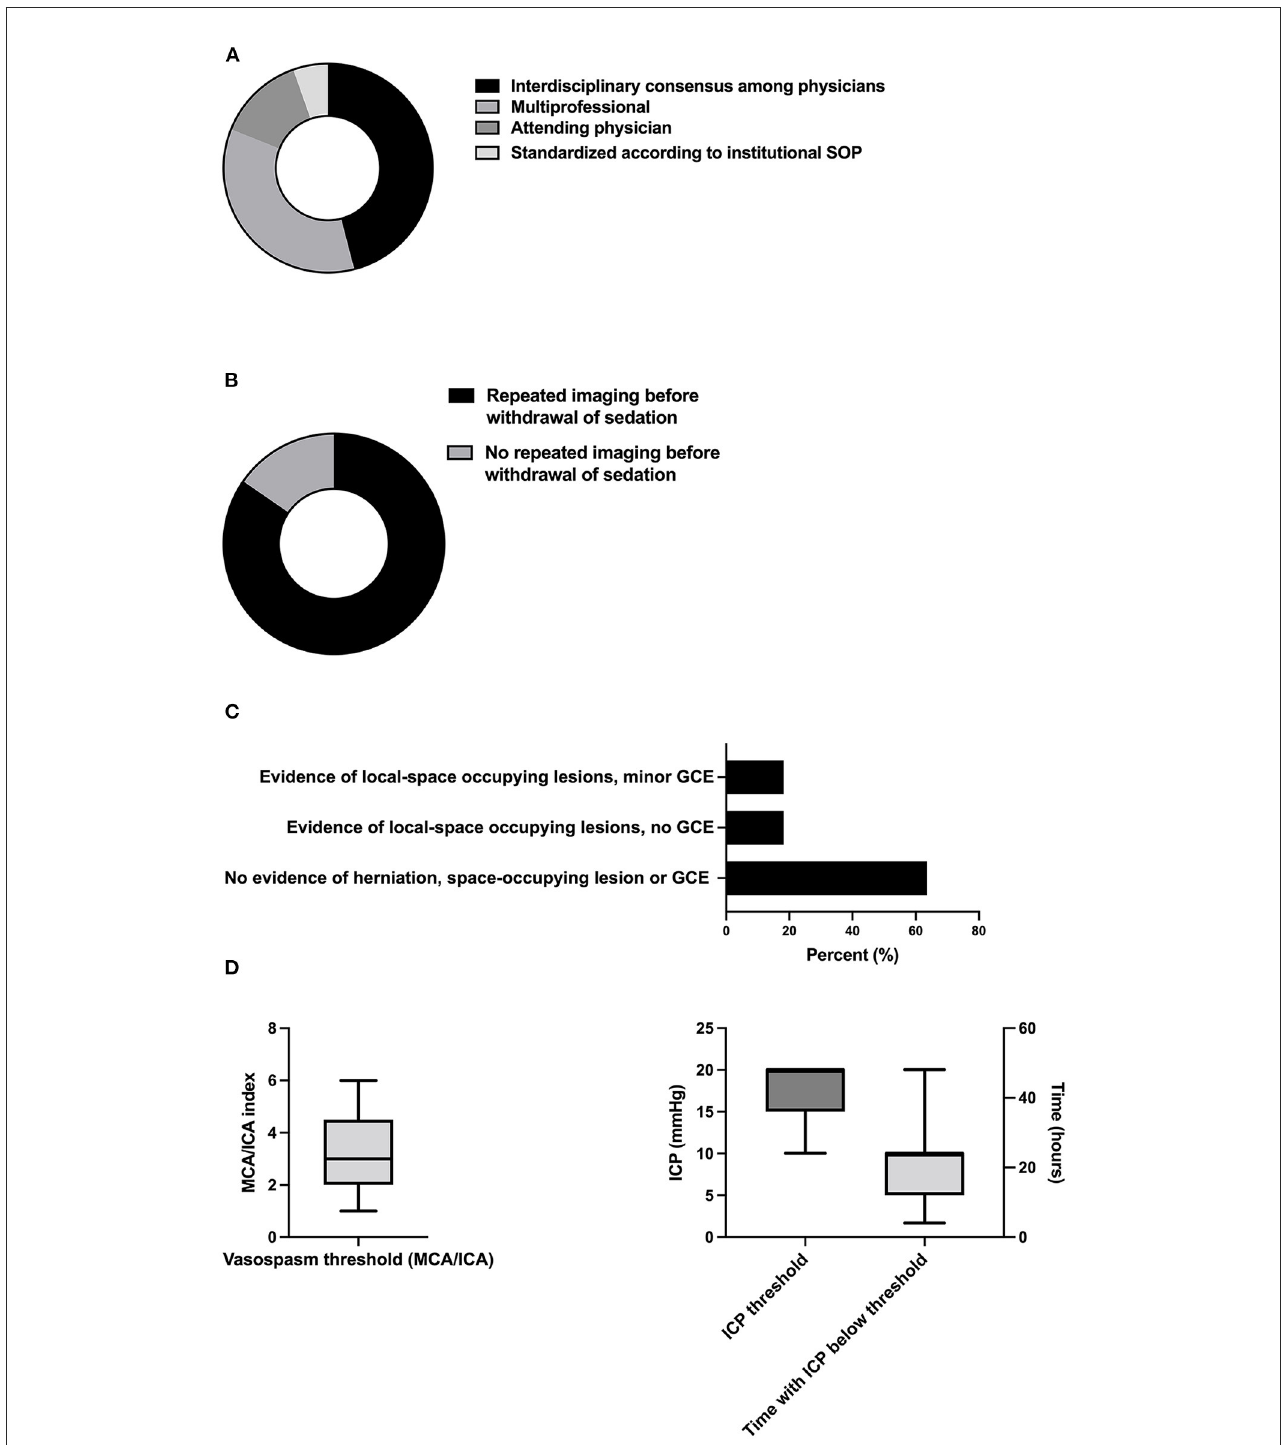
FIGURE5 Decision-making and thresholds of definite withdrawal of sedation. (A) Responsibilities of decision-making ( n = 37), (B) proportion of neurointensivists demanding CT before the withdrawal of sedation ( n = 26), (C) acceptable radiologic lesion patterns and thresholds for intracranial vasospasm ( n = 22), and (D) and ICP in the context of definite withdrawal of sedation ( n = 5 with 2 values excluded due to implausible values). SOP, standard operating procedure; GCE, global cerebral edema; MCA, middle cerebral artery; ICA, internal carotid artery; ICP, intracranial pressure.